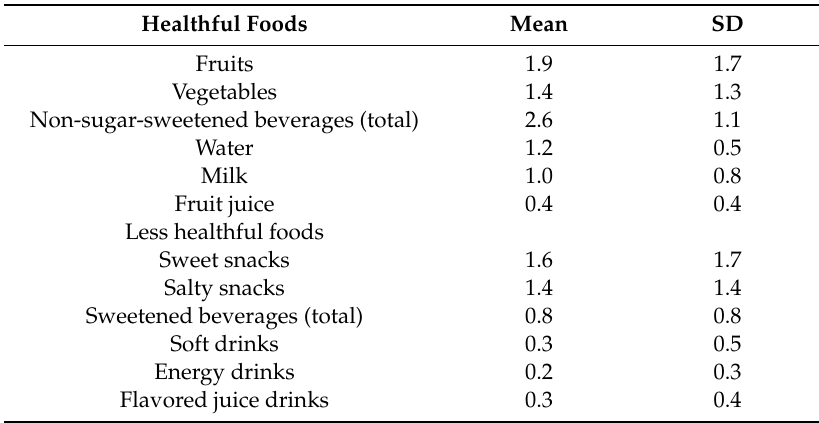
Table 2. Mean servings of foods consumed daily, as reported by the Fueling Learning Through Exercise (FLEX) Food Frequency Questionnaire ( n =